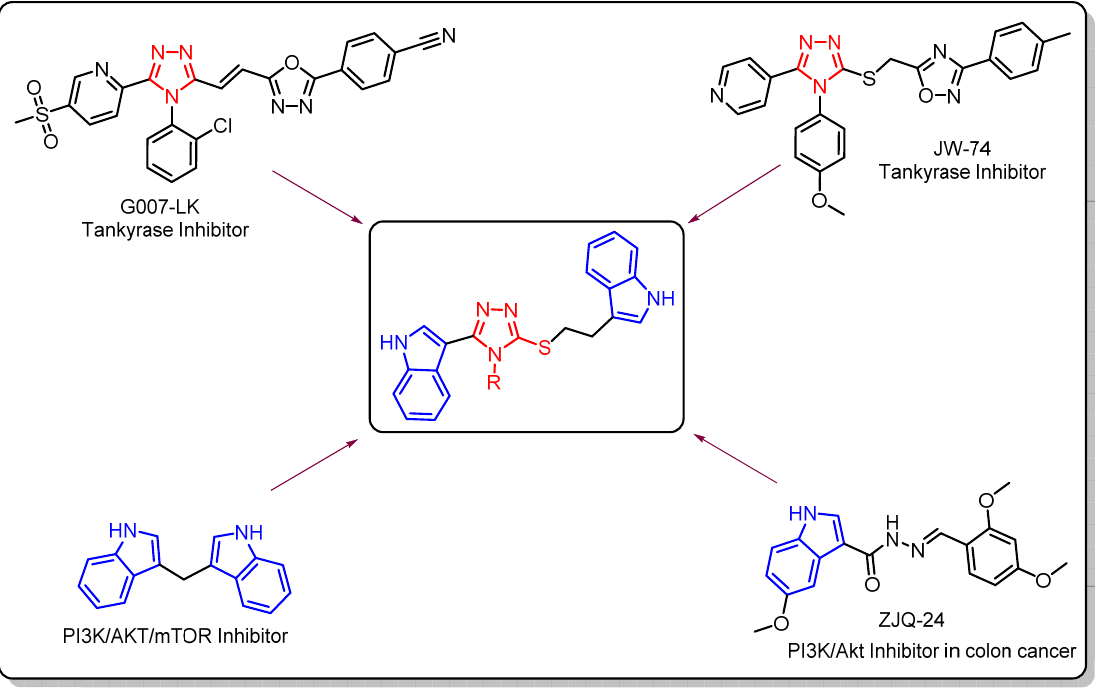
Figure 2. Rational design of target molecules through hybrid conjugation of bioactive ligands.